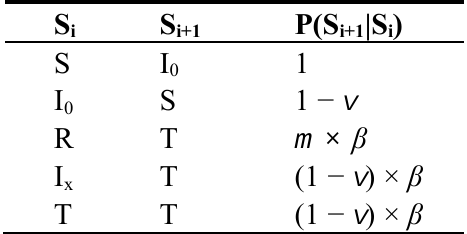
Table 1. Scheduling Probabilities of